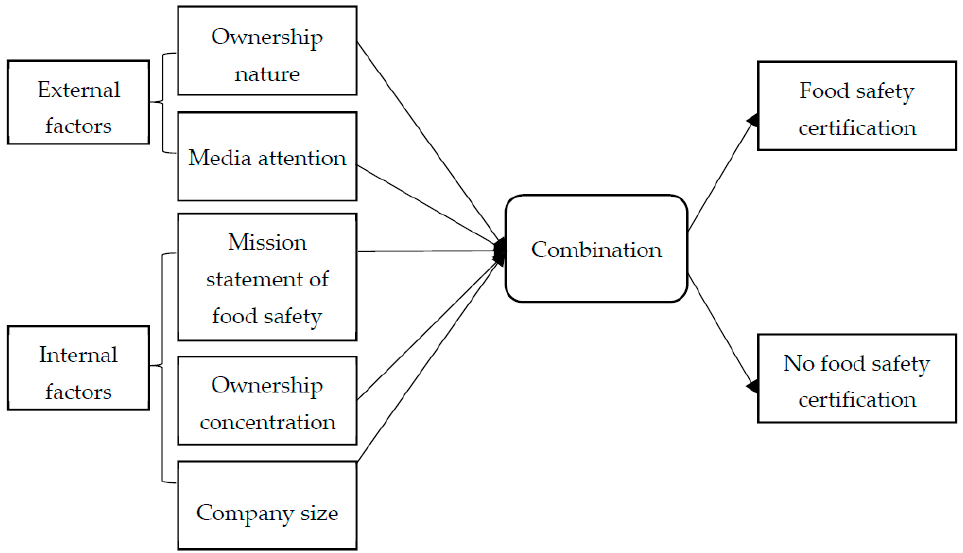
Figure 1. Research model.